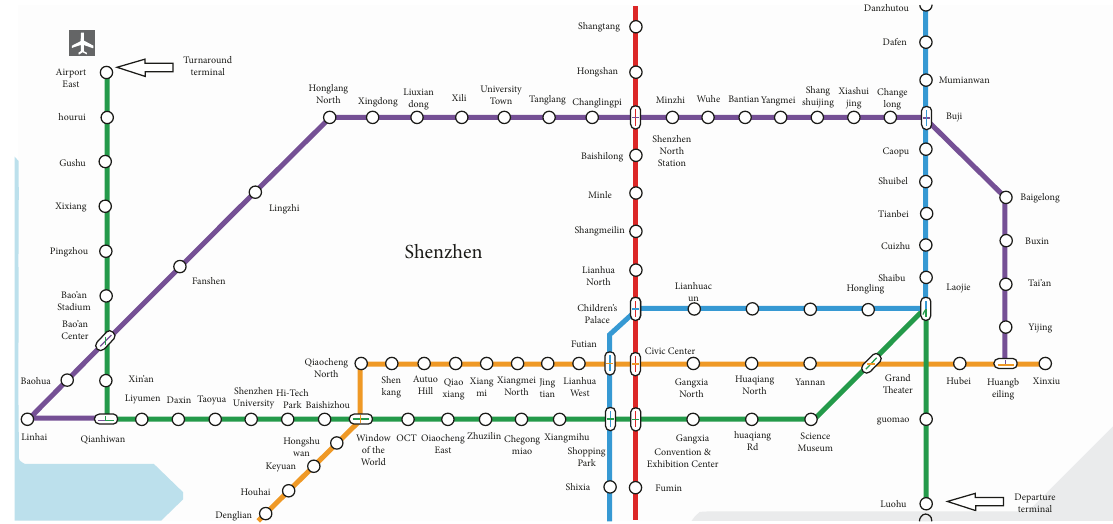
Figure 6: Shenzhen Metro